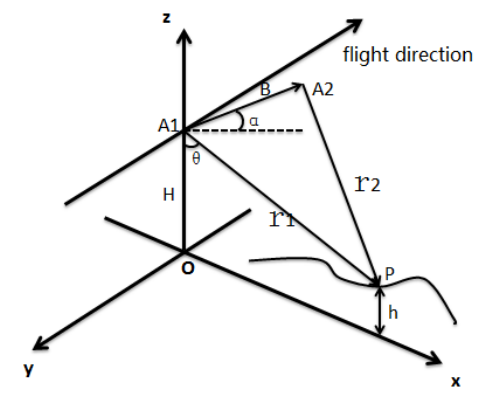
Figure 1 . Airborne InSAR altimetry